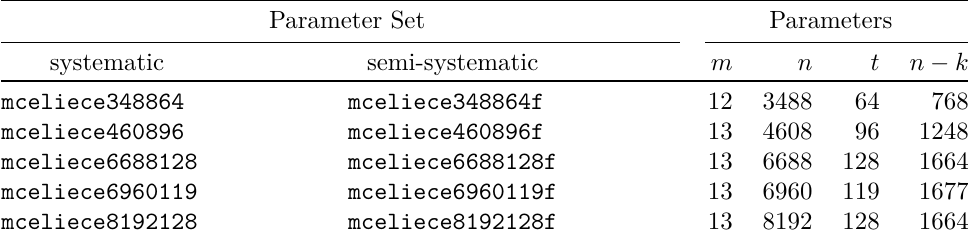
Table 1: Parameter sets of Classic McEliece [ABC + 20].